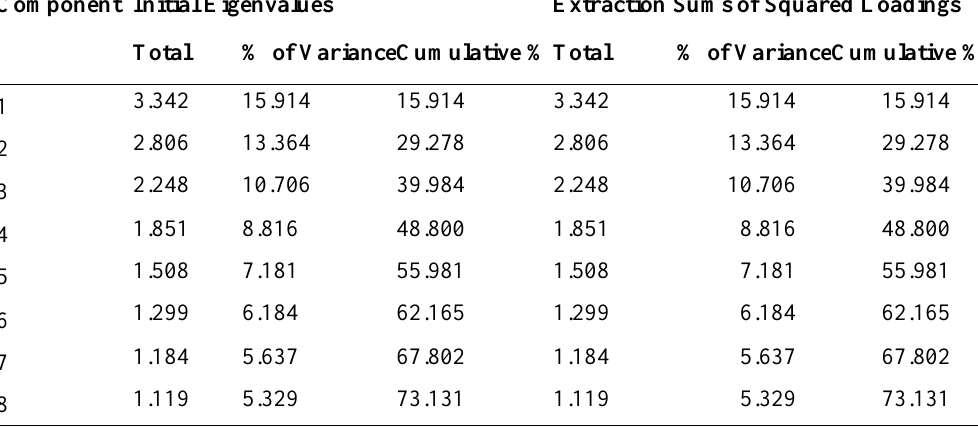
Table 3. Total Variance